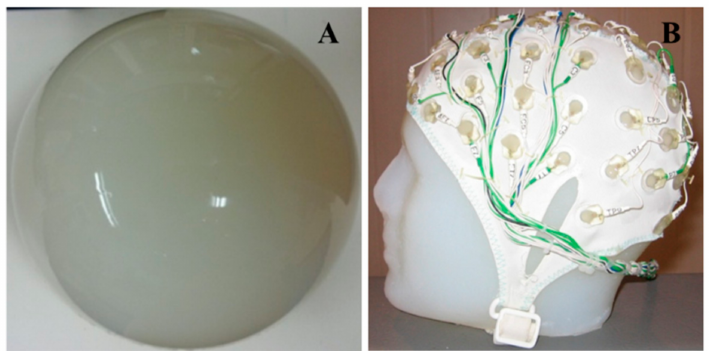
Figure 3. Spherical agar phantom ( A ), and human head-shaped agar phantom ( B